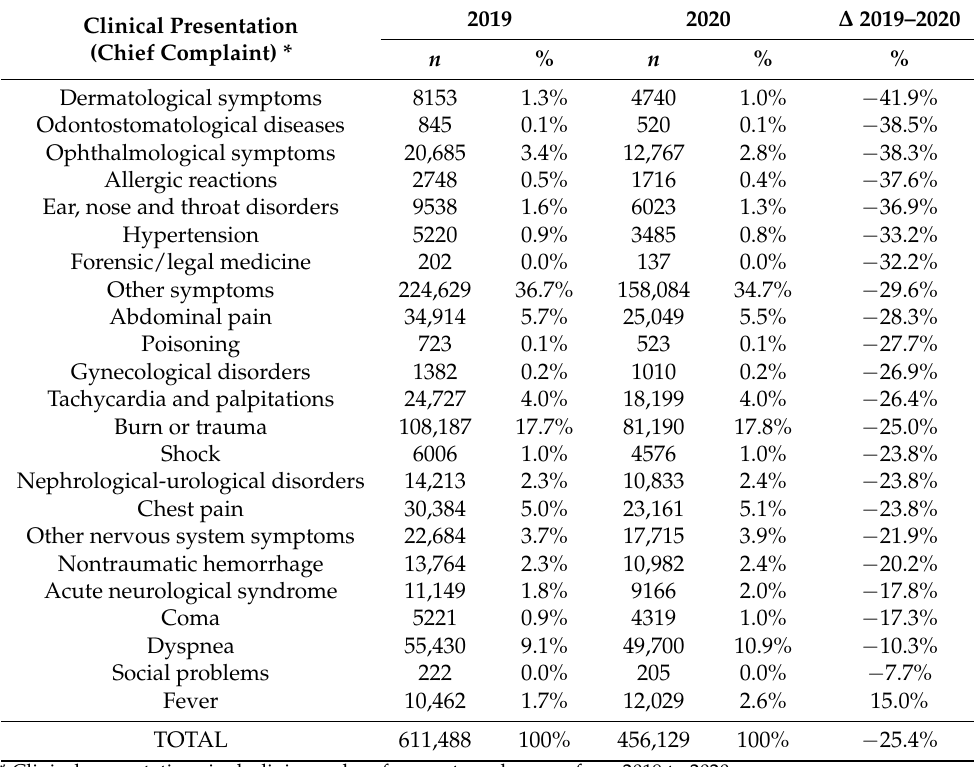
Table 2. Number and proportion of emergency department visits by clinical presentation (chief complaint) in 2019 and 2020, and variation (%) between 2019 and